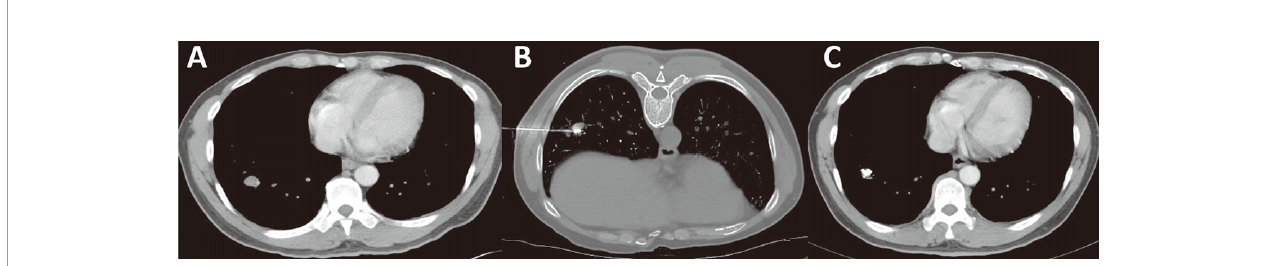
FIGURE 8 | Minimally invasive treatment for HCC with pulmonary oligo-metastasis. (A) CT of an HCC patient showing newly developed right lung oligo- metastatic lesions. (B) Percutaneous particle implantation was performed. (C) A 6-month follow-up CT showed that the metastatic tumor had shrunk and exhibited no activity.